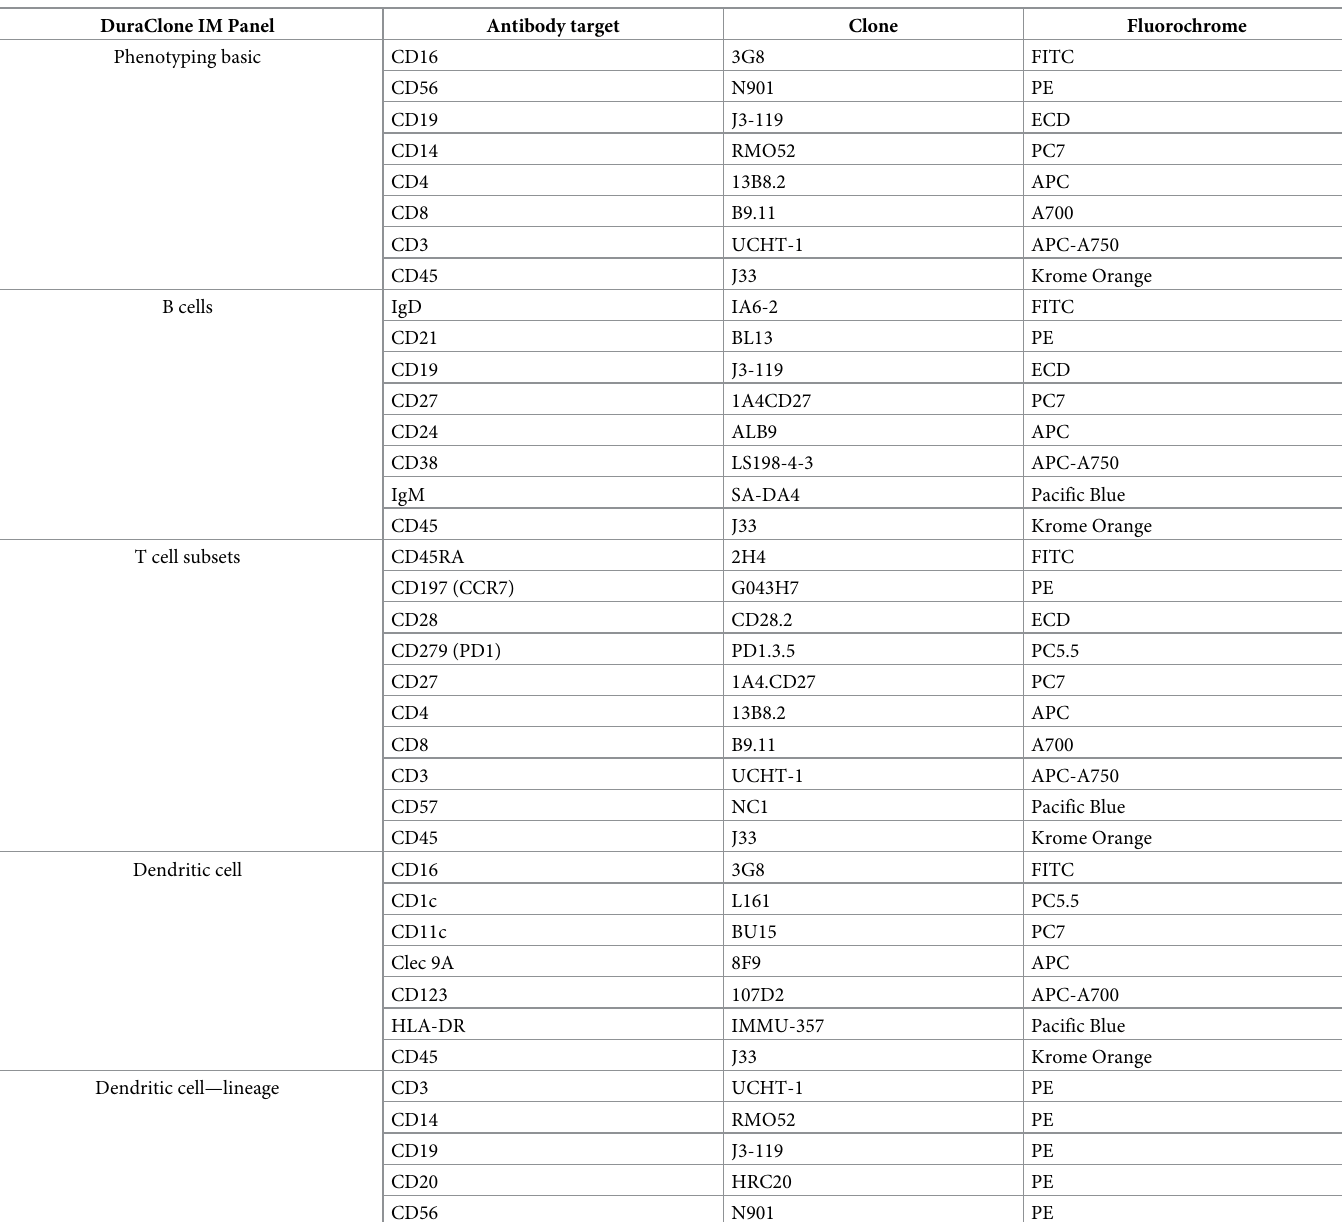
Table 2. Antibodies of the used DuraClone